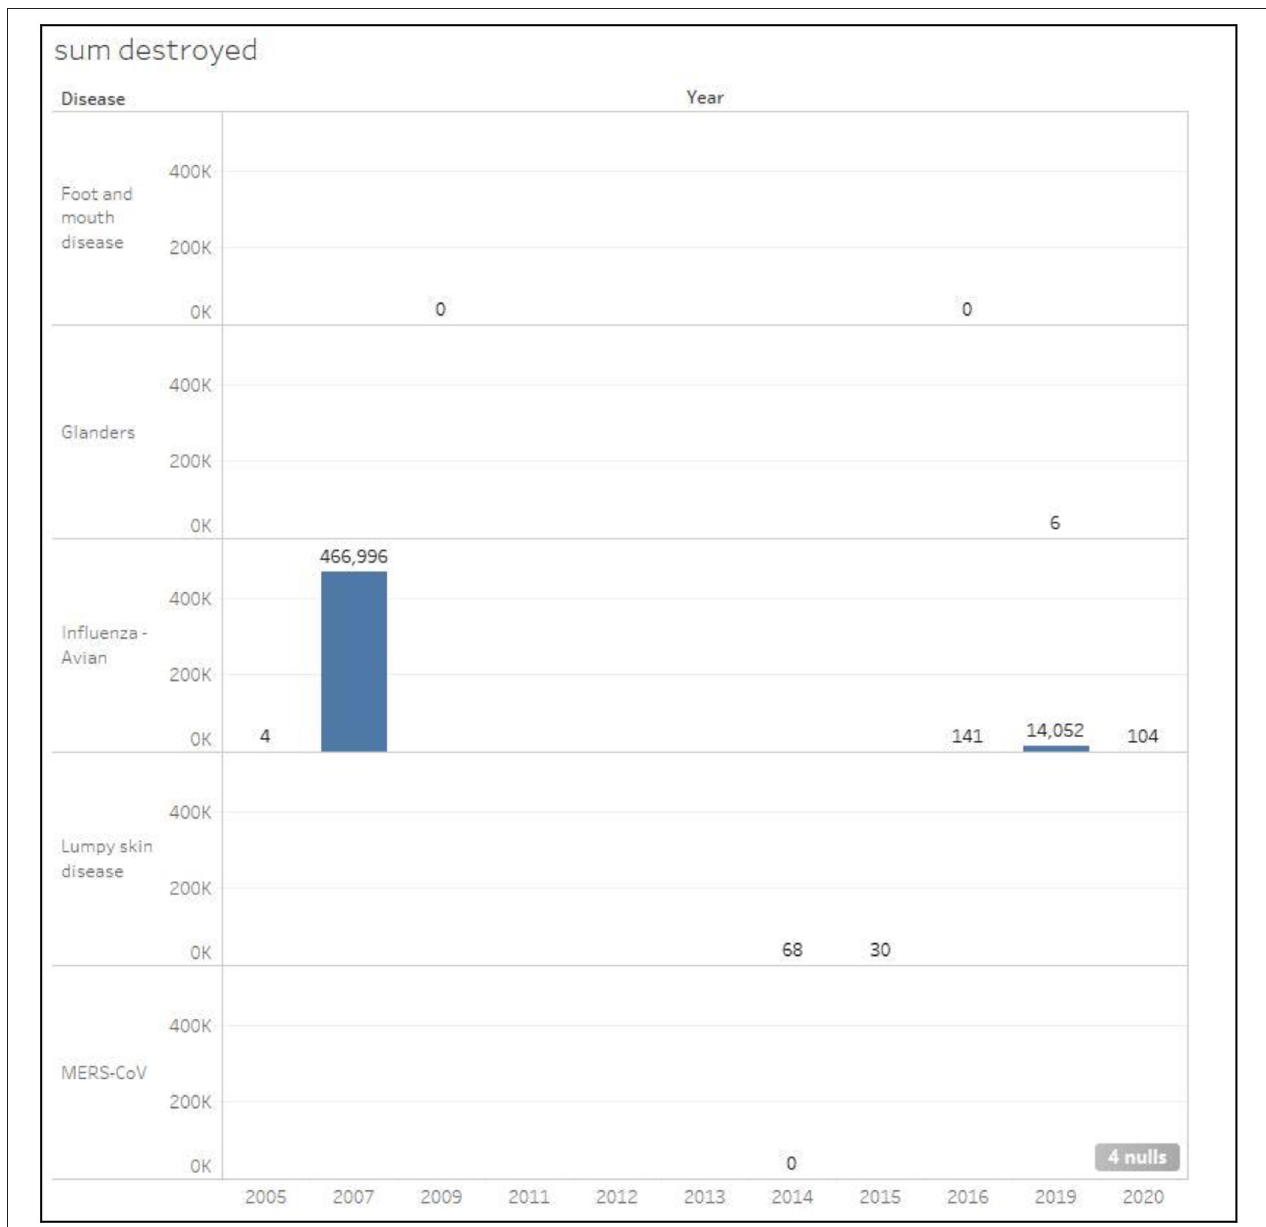
FIGURE 7 | Total number of euthanized cases classified by disease in Kuwait during the period